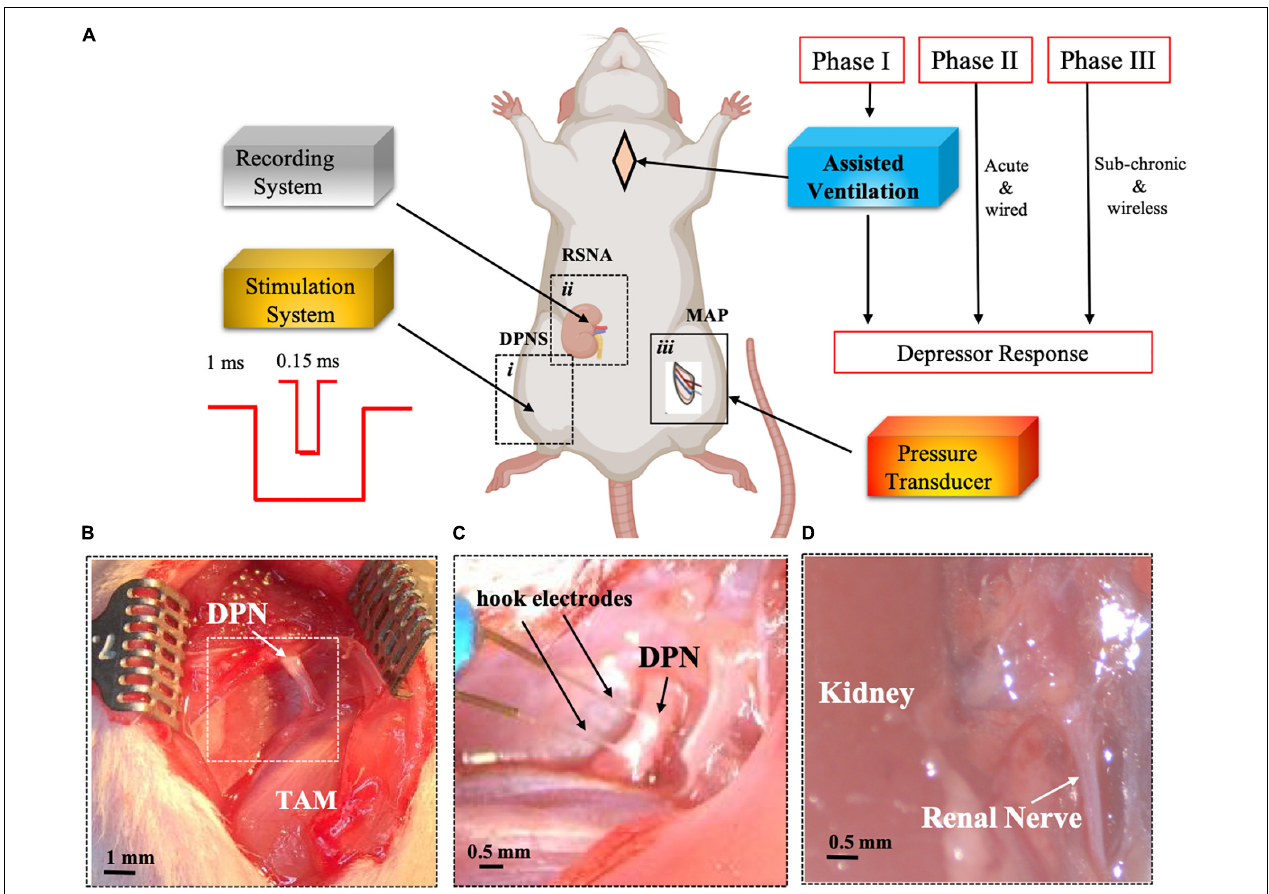
FIGURE 1 | Experimental set-up for DPNS to modulate MAP. Adult SRH rats were anesthetized. Phase I animals received assisted ventilation ( n = 5), and phase II did not ( n = 8), and phase III the MAP was measured by telemetry and DPNS with a wireless system ( n = 11). The effect of DPNS on RSNA and MAP was evaluated, (A) Animal setup: a stimulator system with a pulse generator for short (0.15 ms) or long (1 ms) pulses was connected to a hook electrode placed on the DPN (i). A second electrode was placed on the renal nerve to record neural activity (ii). A catheter was implanted in the femoral artery and connected to a pressure transducer to monitor MAP (iii). Dotted-line inserts (i and ii) show the site where pictures in panels (B–D) were obtained. Photographs of the DPN before (B) and after (C) electrode implantation are displayed. Insert in panel B is magnified in panel C after electrode placement. (D) Identification of renal nerve. SHR, spontaneous hypertensive rats; RSNA, renal sympathetic nerve activity; DPNS, Deep peroneal nerve stimulation; DPN, deep peroneal nerve: MAP, mean arterial pressure; TAM, tibialis anterior